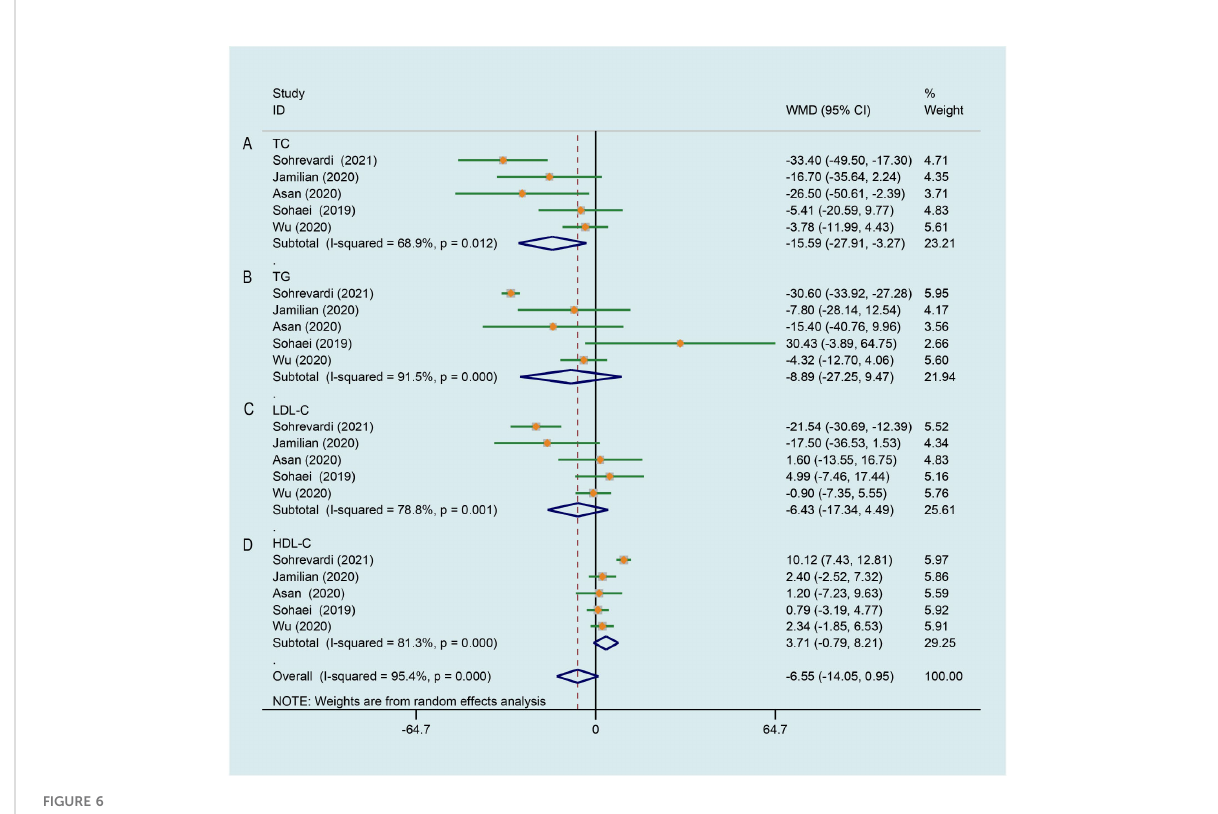
FIGURE 6 Meta-analyses of the effect of curcumin on lipid metabolism. (A) TC, (B) TG, (C) LDL-C, (D)